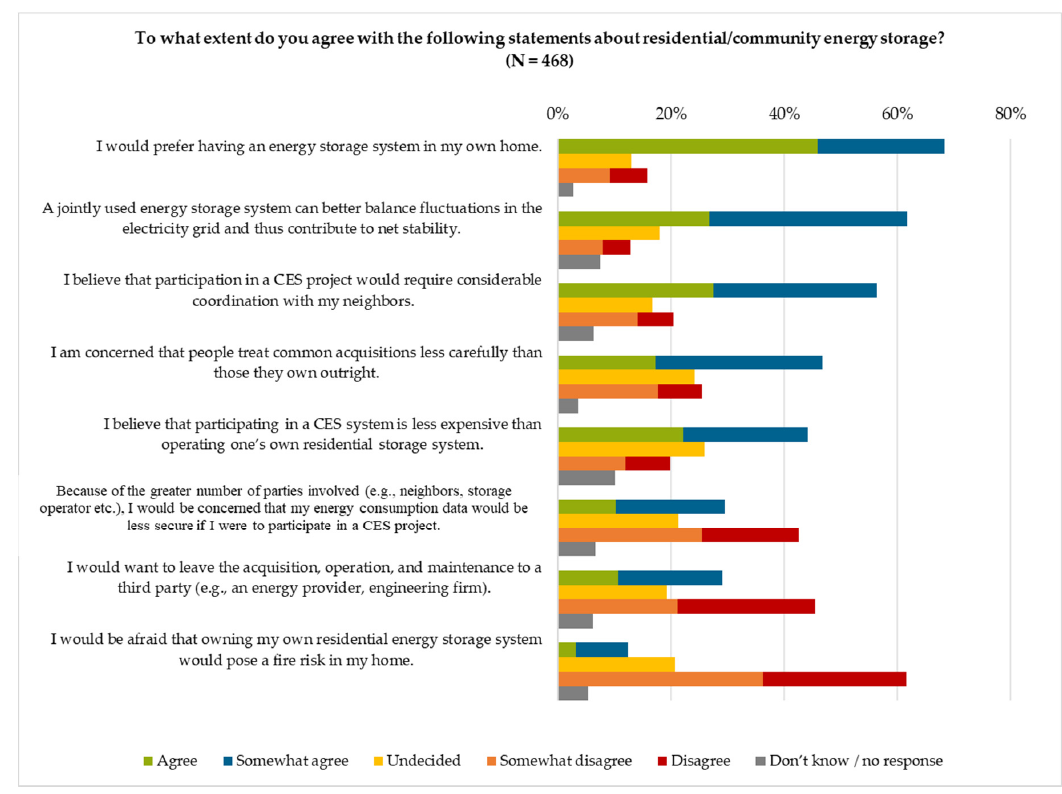
Figure 4. Assessment of (community) energy storage.